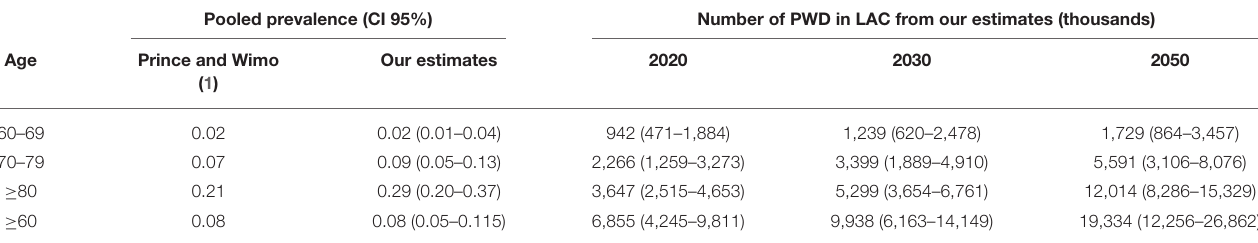
TABLE 2 | Pooled age-specific and age-standardized prevalence and number of PWD in LAC for the years 2015, 2020, 2025, 2030, and 2050. Pooled prevalence (CI 95%) Number of PWD in LAC from our estimates (thousands) Prince and Wimo